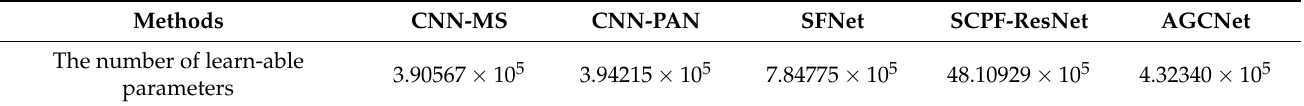
Table 6. Learn-able parameter